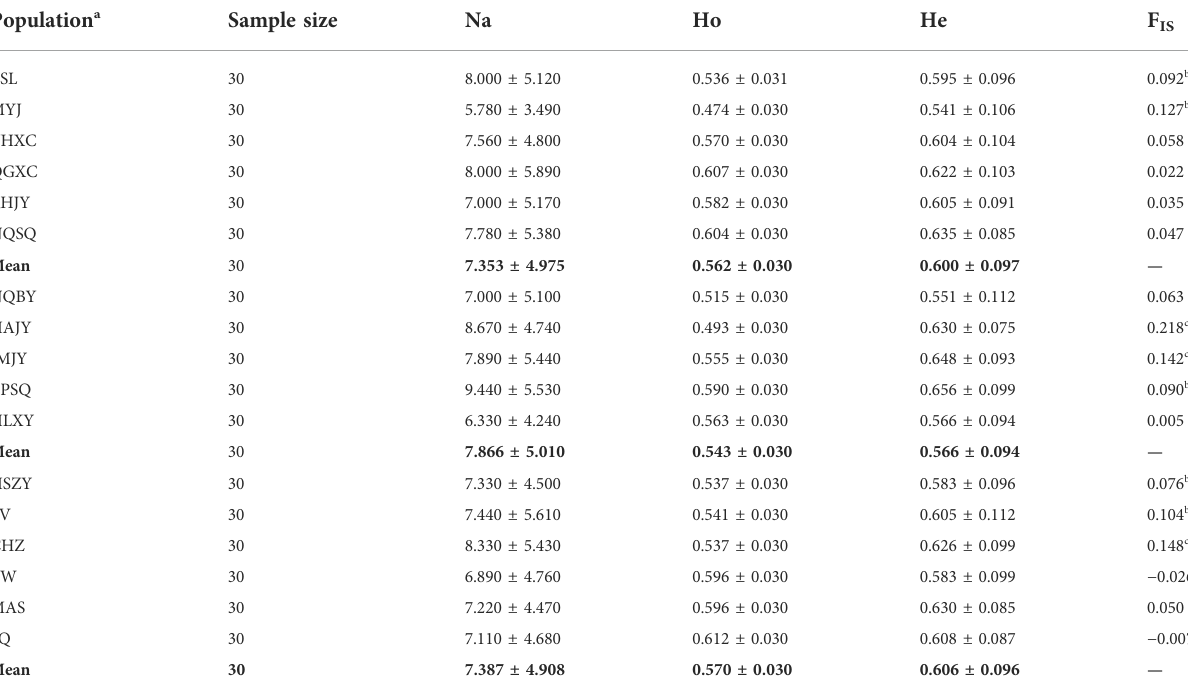
TABLE3 Polymorphism andInbreedingcoef fi cientanalysisat ninemicrosatellitelociin 17 Ae.albopictus specimenscollected from17populationsin Nanjing, China. Population